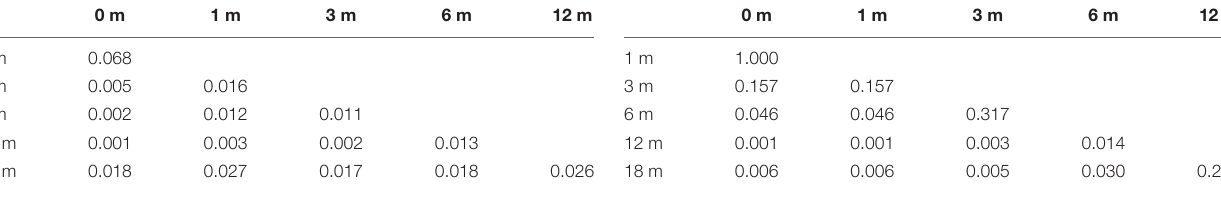
TABLE 4 | Comparison of the percentage of Meaningful Use of Speech Scale (MUSS) scores for each time point in the common cavity deformity (CCD) group. 0 m